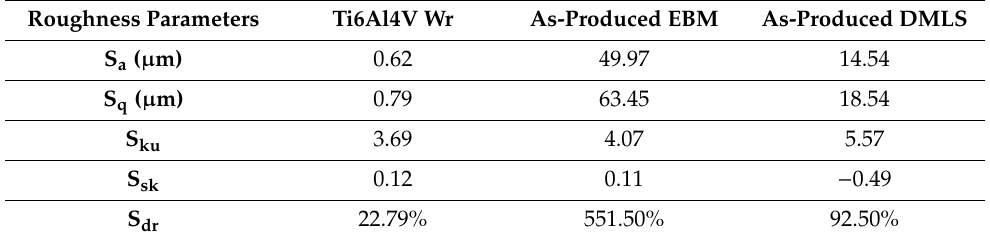
Table4. RoughnessparametersoftheTi-6Al-4VWr, as-producedEBM,andas-producedDMLSspecimens. Roughness Parameters Ti6Al4V Wr As-Produced EBM As-Produced